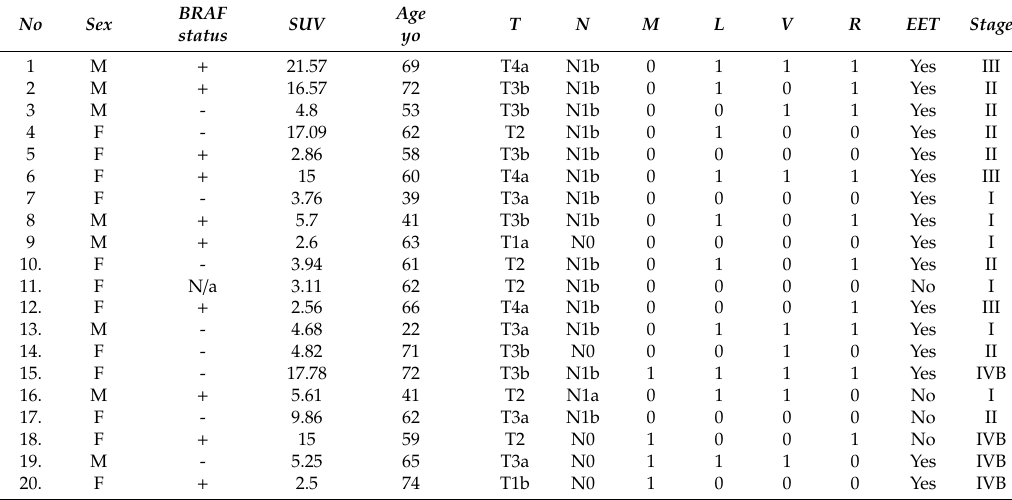
Table 1. Characteristics of patients.